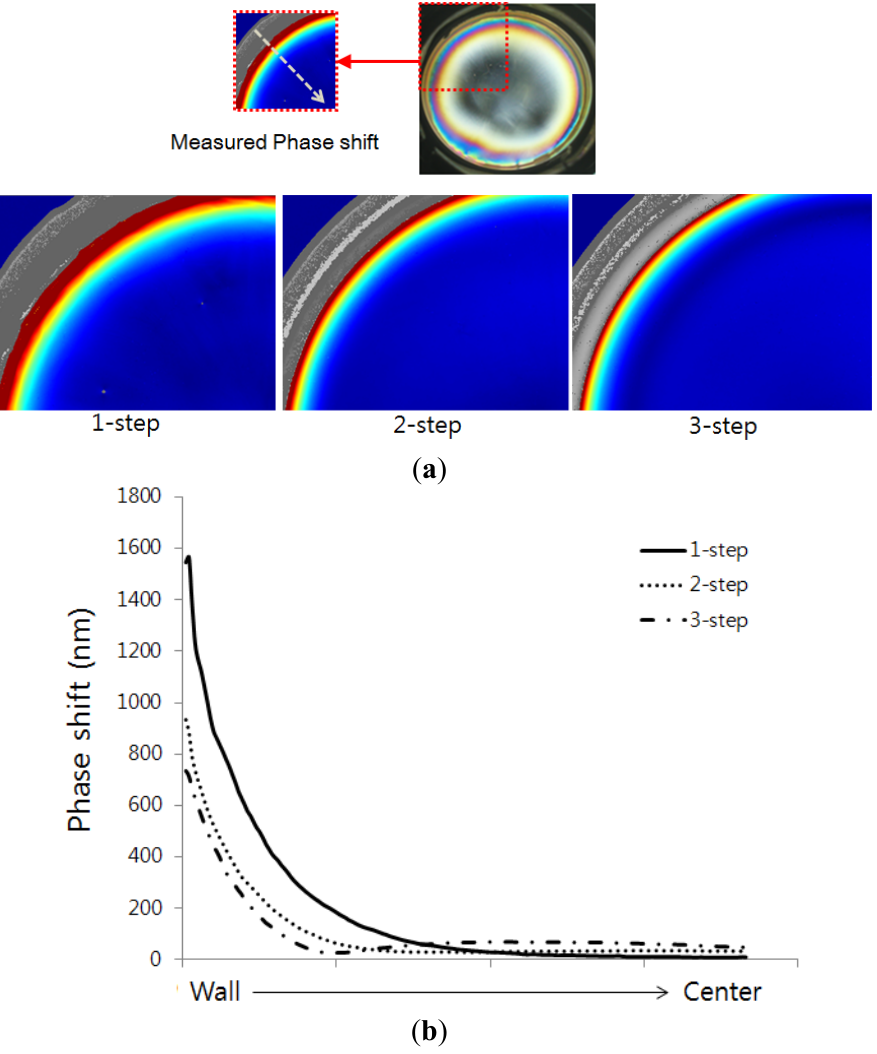
Figure 10. Comparison of birefringence distribution and phase shift after the step cure process. ( a ) Birefringence distribution; ( b ) Phase